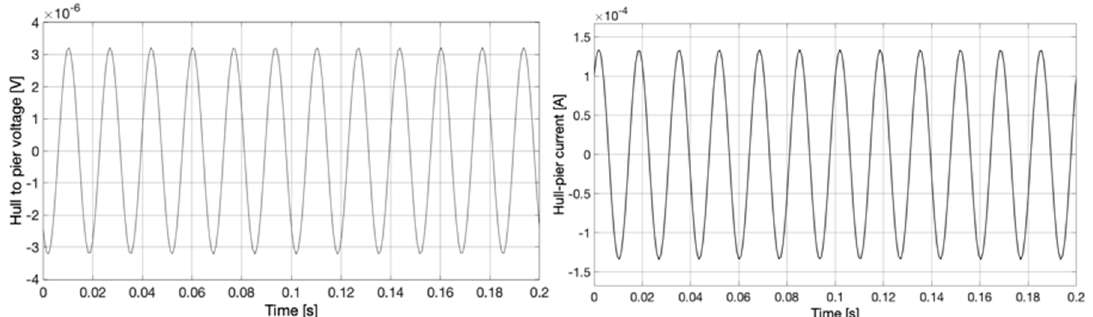
Figure 13. Simulink Model #2 numerical experiments results for asymmetrical shore cables capacitances (0.030, 0.028, 0.033 μ F), asymmetrical vessel cables capacitances (0.0030, 0.0028, 0.0033 μ F), asymmetrical supply voltages (±3 V) and stray current path resistance equaling 0.024 ohms. Hull—pier AC voltage ( left ), stray alternating current waveform ( right ).